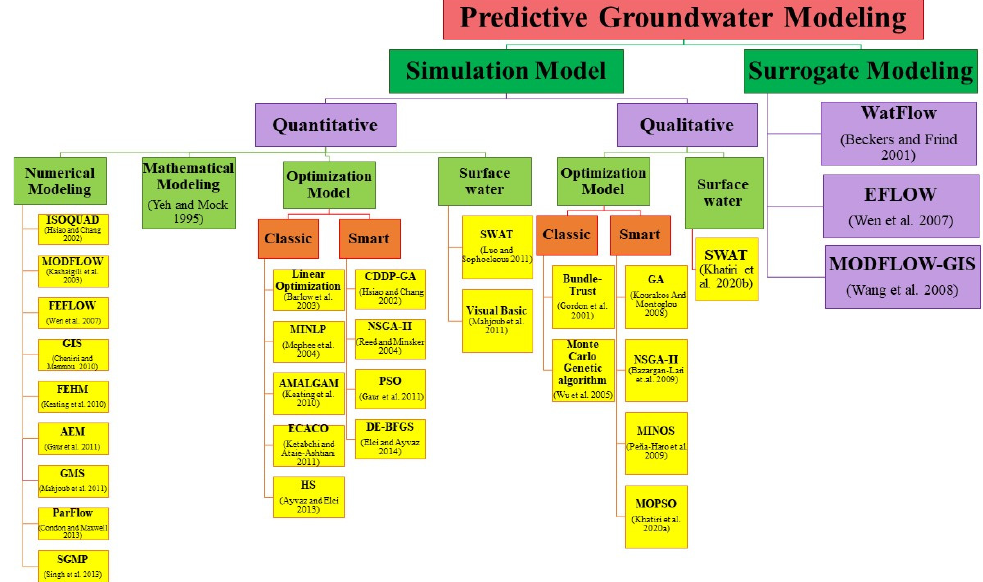
Figure 3. A classification of predictive groundwater modeling [8,16,29–51].